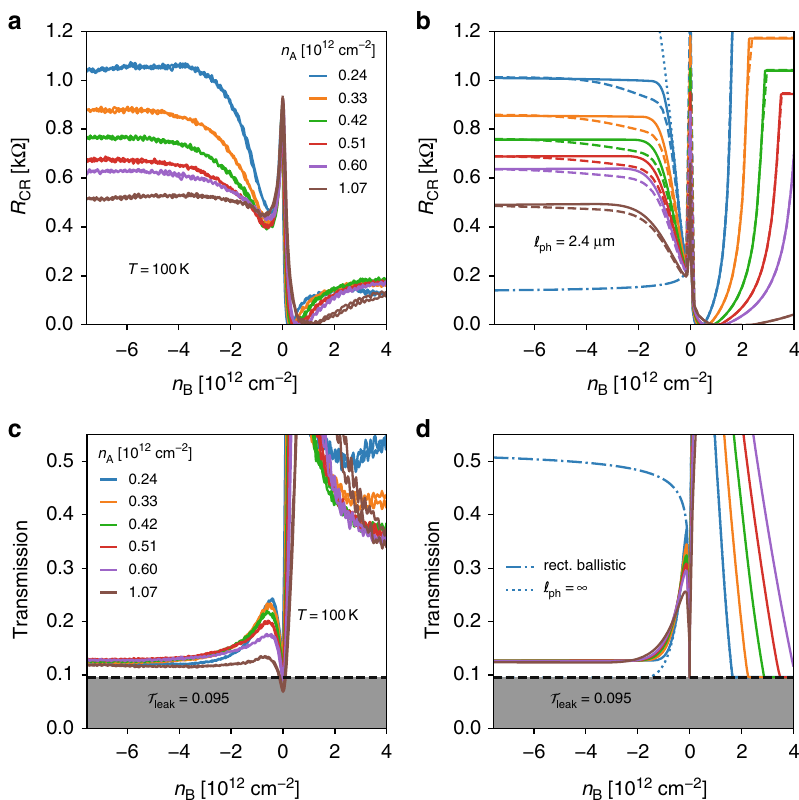
Fig. 2 Corner-re fl ector transfer characteristics in the incoherent regime ( T = 100 K): theory and experiment. a , c Experimental device resistance (quasi-DC) and transmission as a function of barrier doping n B for various access doping n A (c.f. red box in Fig. 1f). b , d Solid lines: resistance and transmission from simpli fi ed equation (Supplementary Equation-1), using a scattering length of ‘ ph = 2.4 μ m and a junction length of d = 30 nm, saturating in the n – p + – n regime to the plateaus given by Eq. (1). Dashed lines: resistance from complete ray-tracing simulation. Dashed-dotted blue lines: resistance/transmission of a rectangular ballistic n – p – n barrier of same area and junction length and n A = 0.24 × 10 12 cm − 2 . Dotted blue lines: CR resistance/transmission with in fi nite scattering length in the same conditions. A leak transmission of 9.5% was taken into account in all